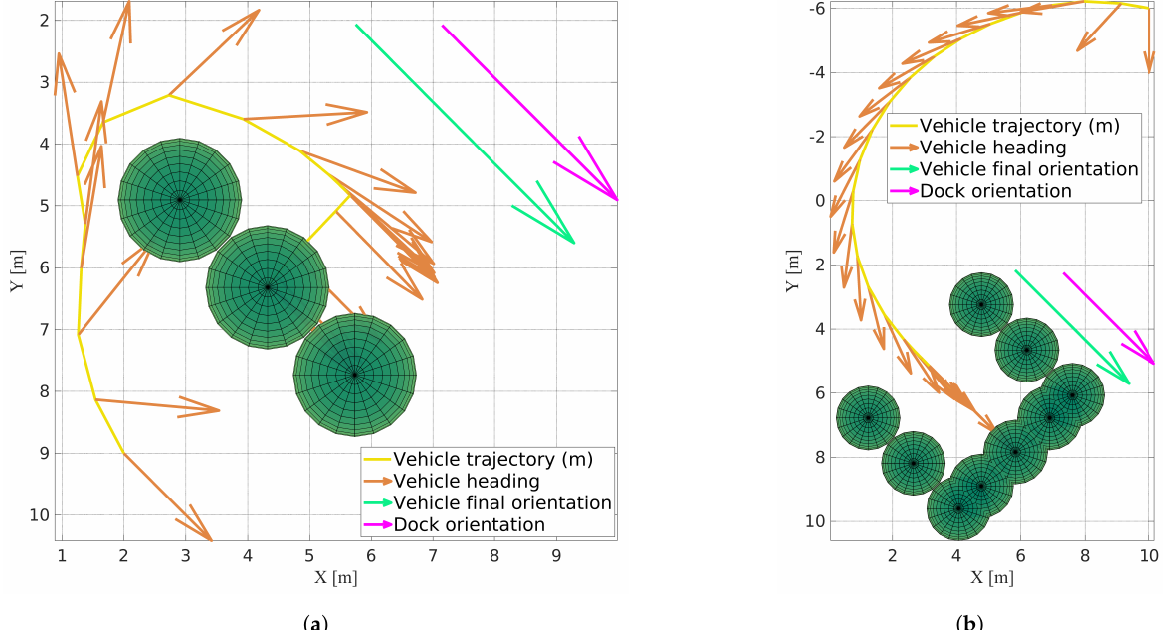
Figure 9. X300: ( a ) Maneuver showing the vehicle performing docking to a docking station, going around without collision, ( b ) Maneuver showing the vehicle performing docking into a tight space inside a moving docking station, starting from a distance.